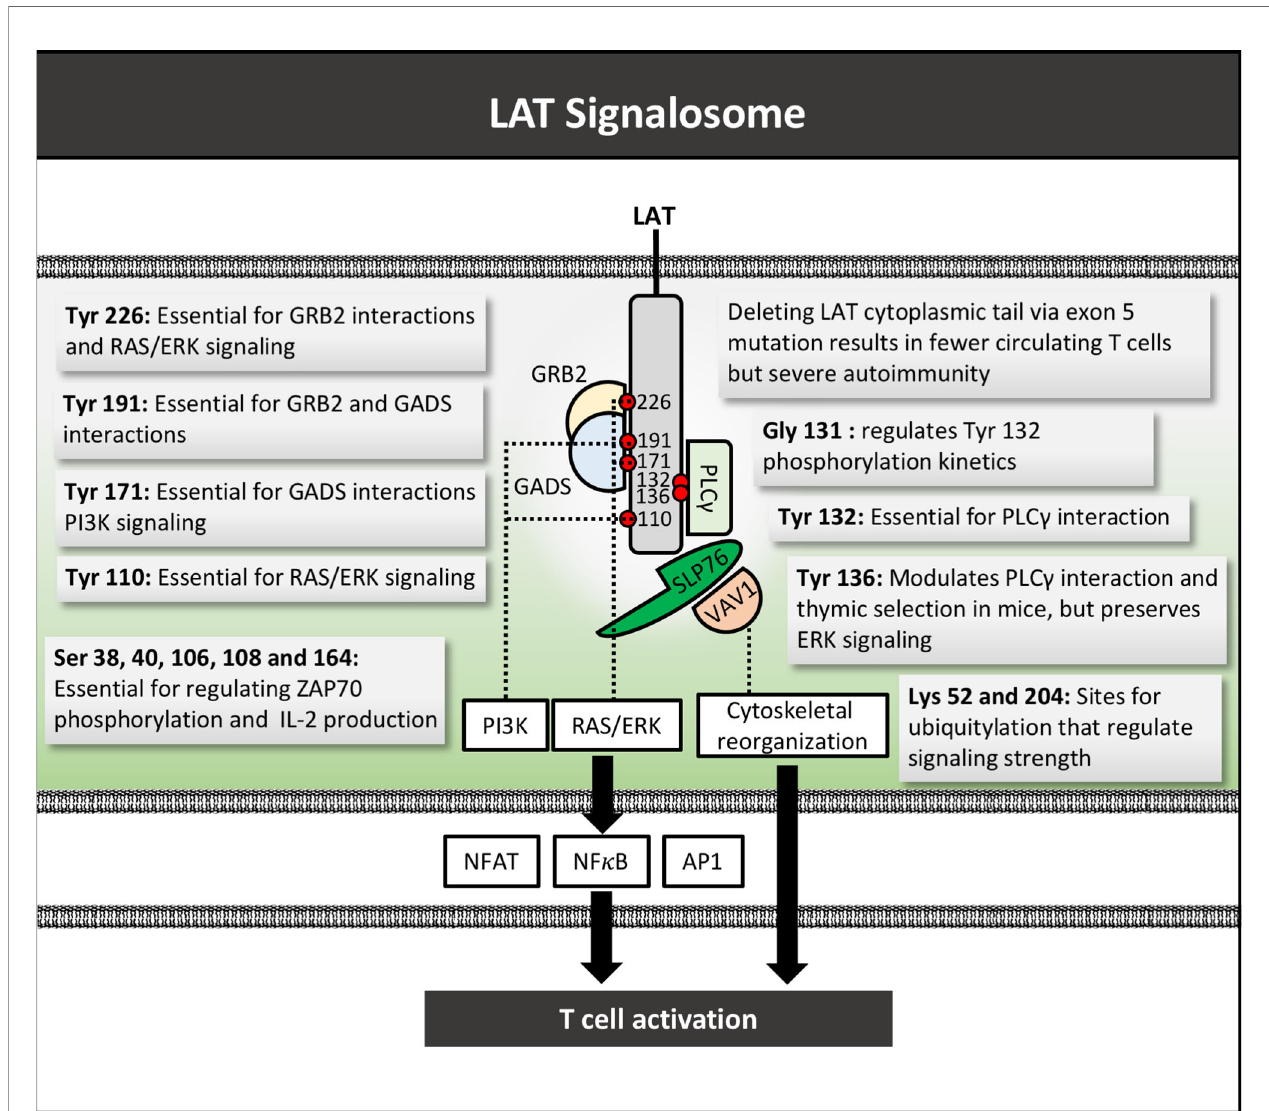
FIGURE 5 | LAT signalosome structure and function. LAT signalosome schematic structure with function of key tyrosine residues depicted by their respective numbers, as well as mutations and respective phenotypes. Several key LAT signaling partners are depicted. Red circles denote phosphate groups. Tyr, Tyrosine; Gly, glycine; Ser, serine; Lys,